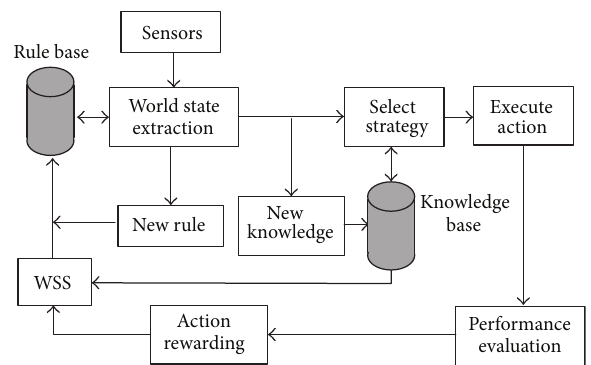
Figure 2: The flow chart of improved Q -learning algorithm for mobile